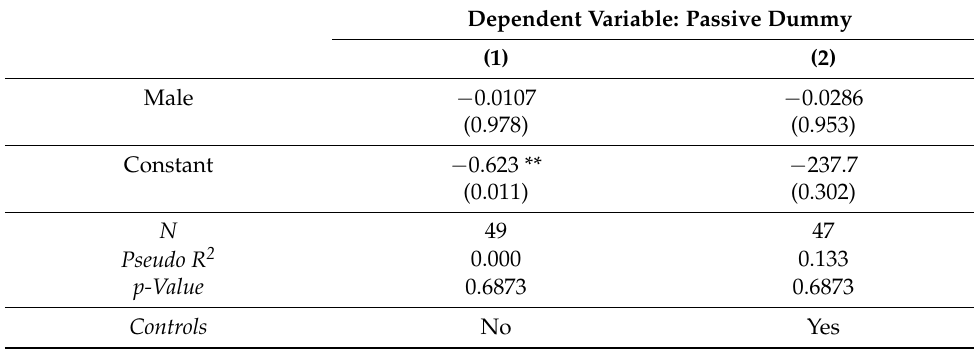
Table A3. Probit regression results for the endogenous